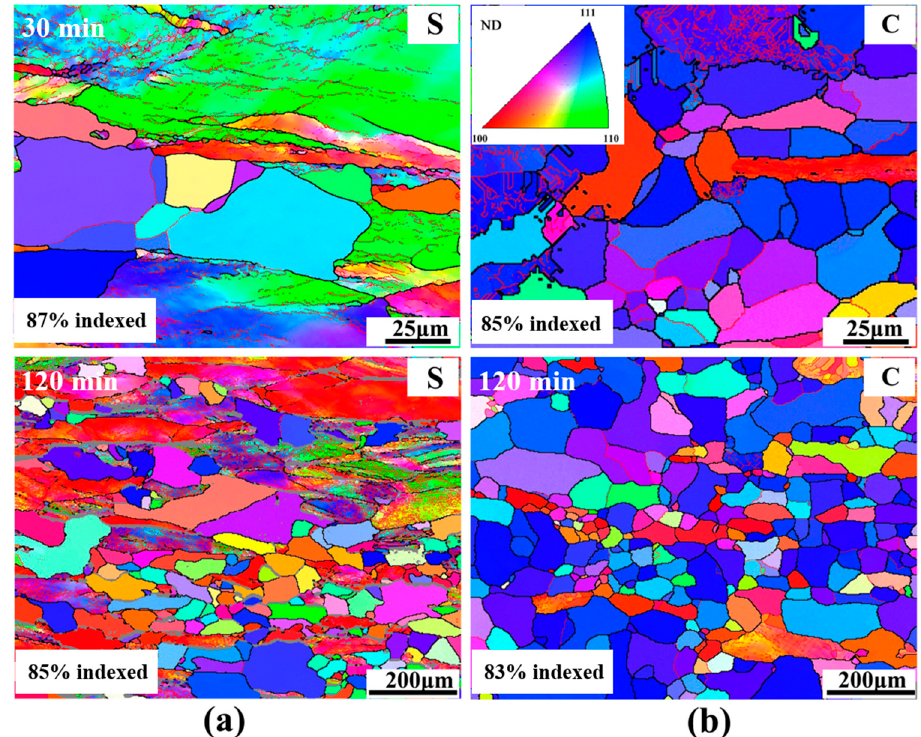
Figure 4. Orientation imaging map (OIM) of 70% clock-rolled Ta when annealed at 950 °C for different times (30 min and 120 min) ( a ) surface layer ( b ) central layer. Note that “S” and “C” represent “surface layer” and “center layer”, respectively.